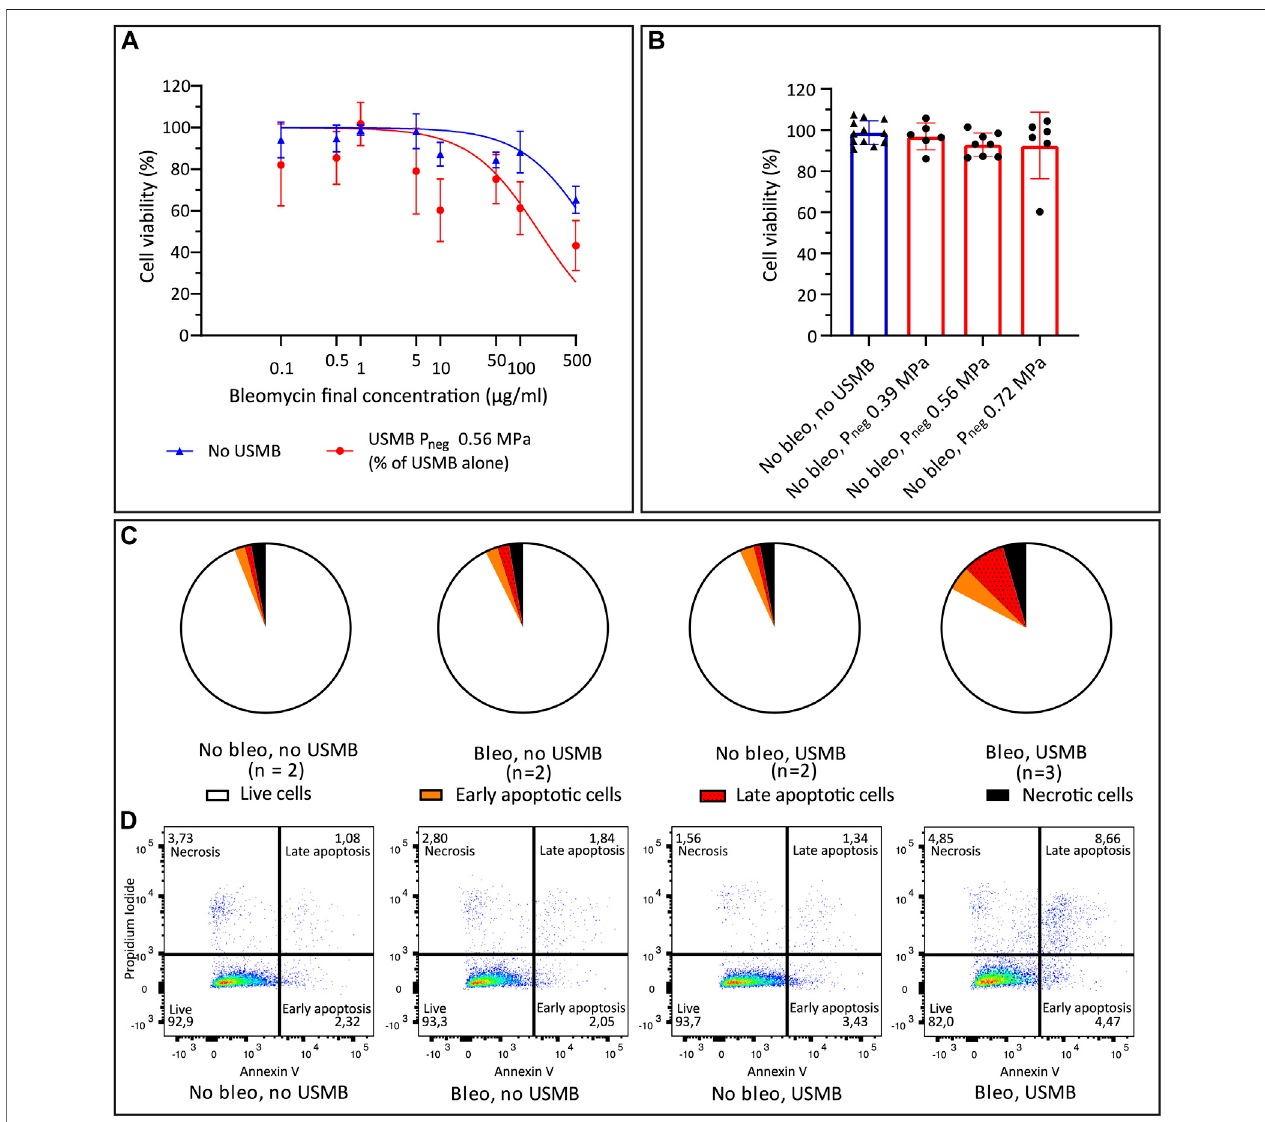
FIGURE5| Cellviabilityafterbleomycin ± USMBusingthecustom-buildUSset-upwithsingleelementtransducer. (A) Nonlinearleast-squaresregressionofbleomycin concentrationversuscellviabilitypercentage(relativetosampleswithoutbleomycin),with(redcircles)andwithout(bluetriangles)USMBatP neg 0.56 MPa.Symbolsandbars indicatemeanandSD( n ≥ 3). (B) Cellviabilitywith(red,circles)orwithout(blue,triangles)USMBaloneatthreepressures,symbolsindicateindividualmeasurementsandbars indicatemeanandSD( n ≥ 6). (C) FlowcytometryanalysisofPropidiumIodideandAnnexinVstaining48 hafterbleomycin10 μ g/mlorNaCl0.9%withorwithoutUSMB atP neg 0.56 MPa.Piechartsrepresentthemeanofthesampleswith n (cid:1) 2or(forbleomycin+USMBsamples) n (cid:1) 3. (D) Representativedotplotsof fl owcytometryanalysis shown in (C) . More apoptosis was observed after bleomycin + USMB. Bleo: bleomycin; P neg : Peak negative pressure; USMB: ultrasound and microbubbles.